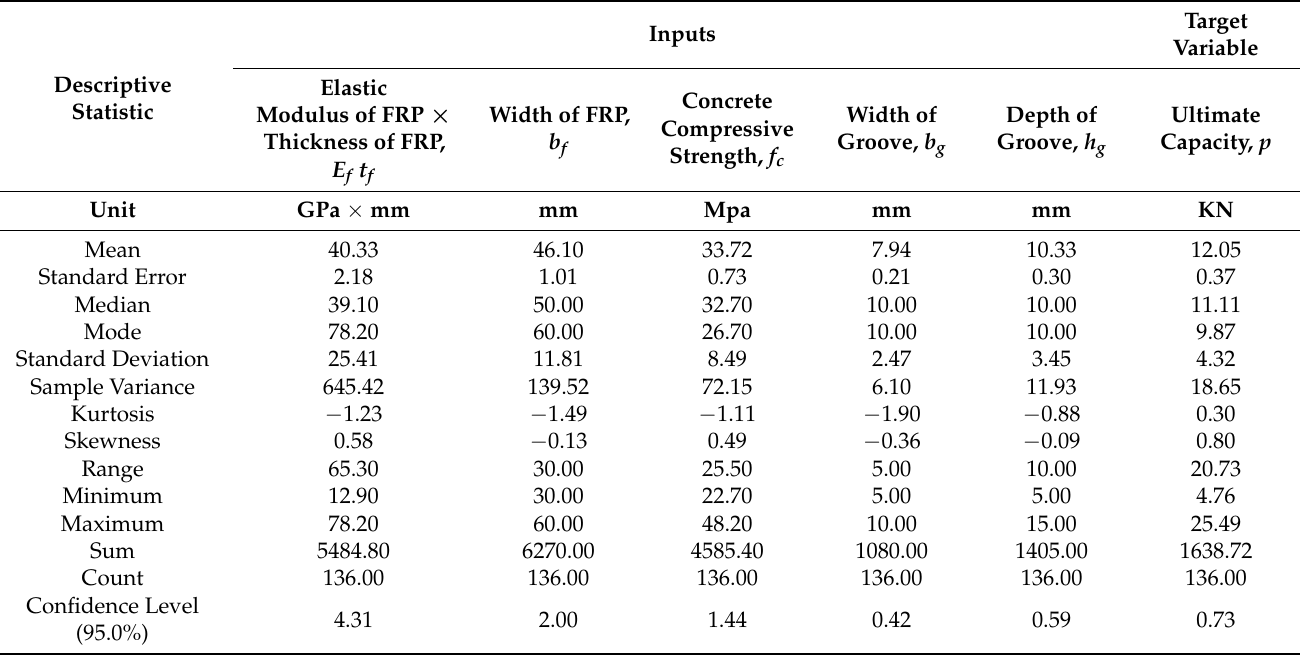
Table 1. Descriptive statistics of the collected